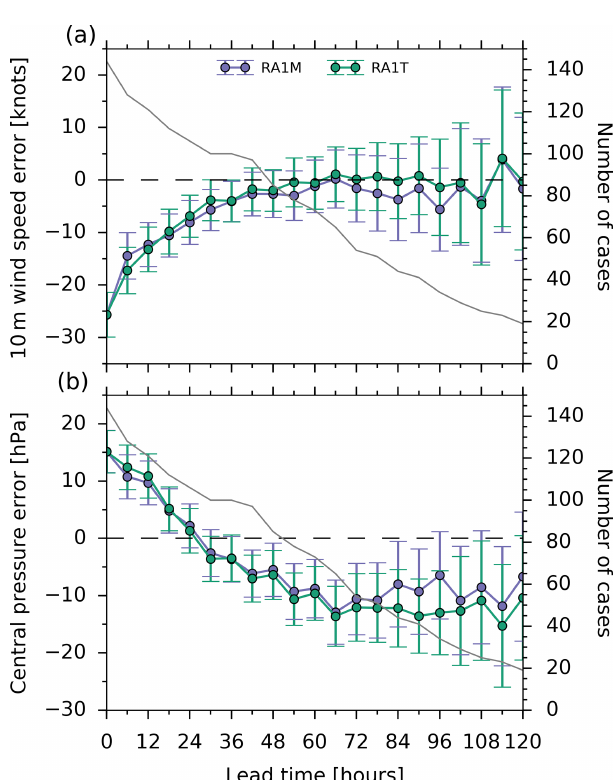
Figure 19. Mean bias in (a) maximum surface wind speed and (b) central pressure as a function of lead time for the RAL1-T and RAL1-M regional models. Error bars are 95% confidence intervals on the mean. The solid grey lines indicate the number of cases at each lead time (see the right-hand axis of each